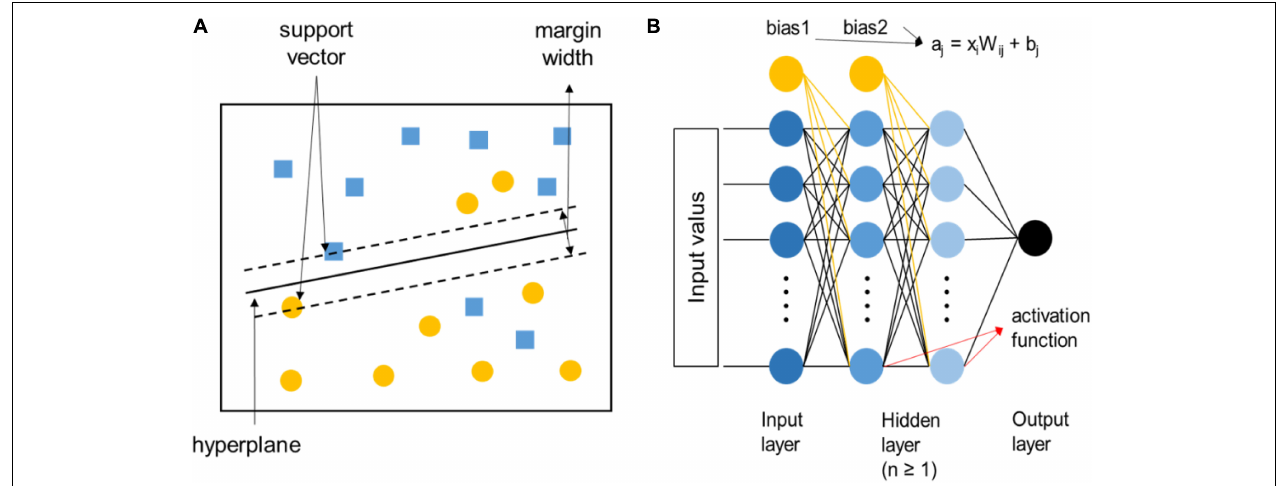
FIGURE 5 | (A) The diagram of the linear support vector machine, where the two different symbols represent two various types of data samples, respectively. (B) The diagram of artificial neural networks.